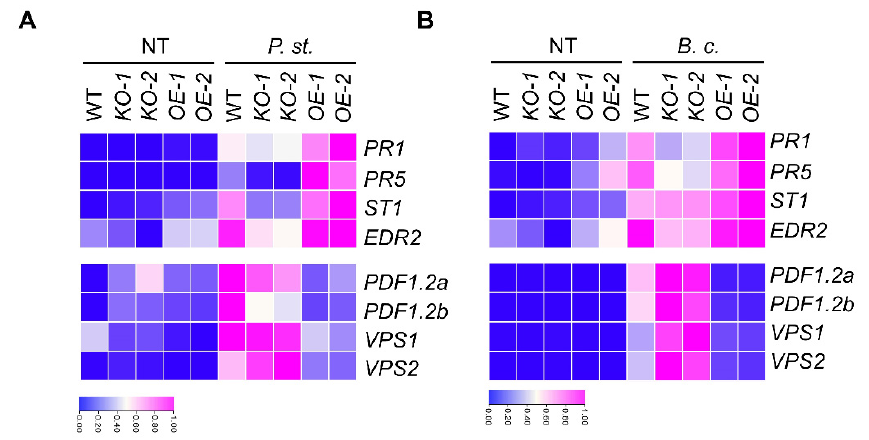
Figure 5. MACP2 differentially modulate plant sensitivities to fungal and bacterial pathogens via SA signaling pathway. Heatmaps show the fold change of key regulators in SA and JA signaling pathways in wild-type, MACP2-KO mutants, and MACP2-OEs plants after infection with Pst DC3000 ( A ) and B. cinerea ( B ). The transcriptional profiles of relative gene expression values were analyzed using the TB tools.